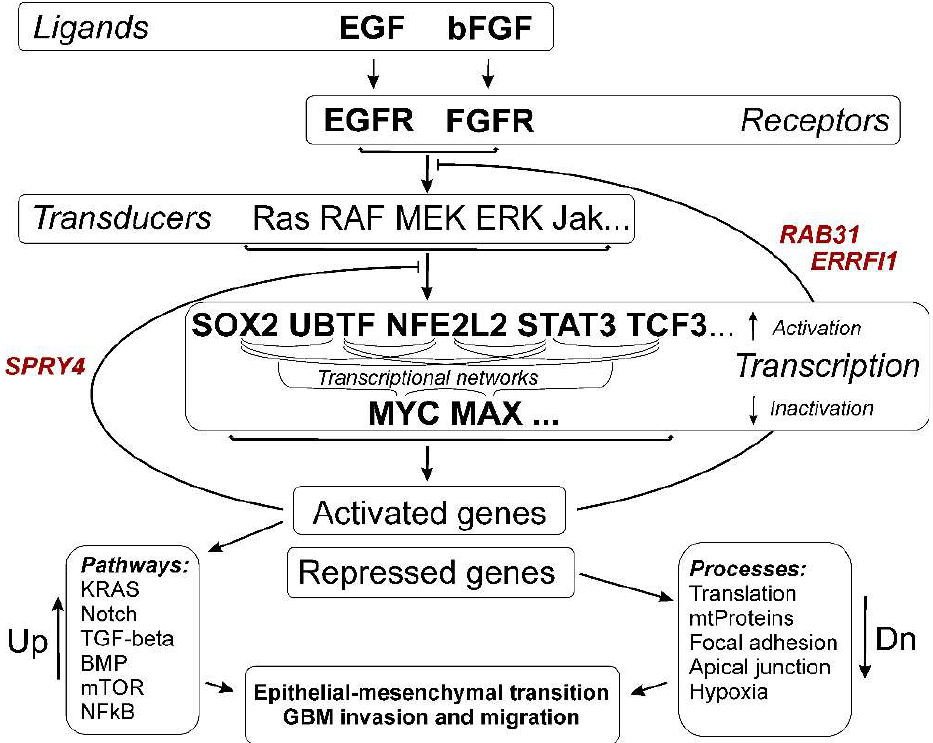
Figure 9. General scheme of processes in glioma cells under conditions of neurosphere formation. The SPRY4, ERRFI1 , and RAB31 genes are indicated, the activation of which provides inverse regulation of both the formation of neurospheres and the processes of tumor progression associated with them, including EMT, invasion, and migration of cancer